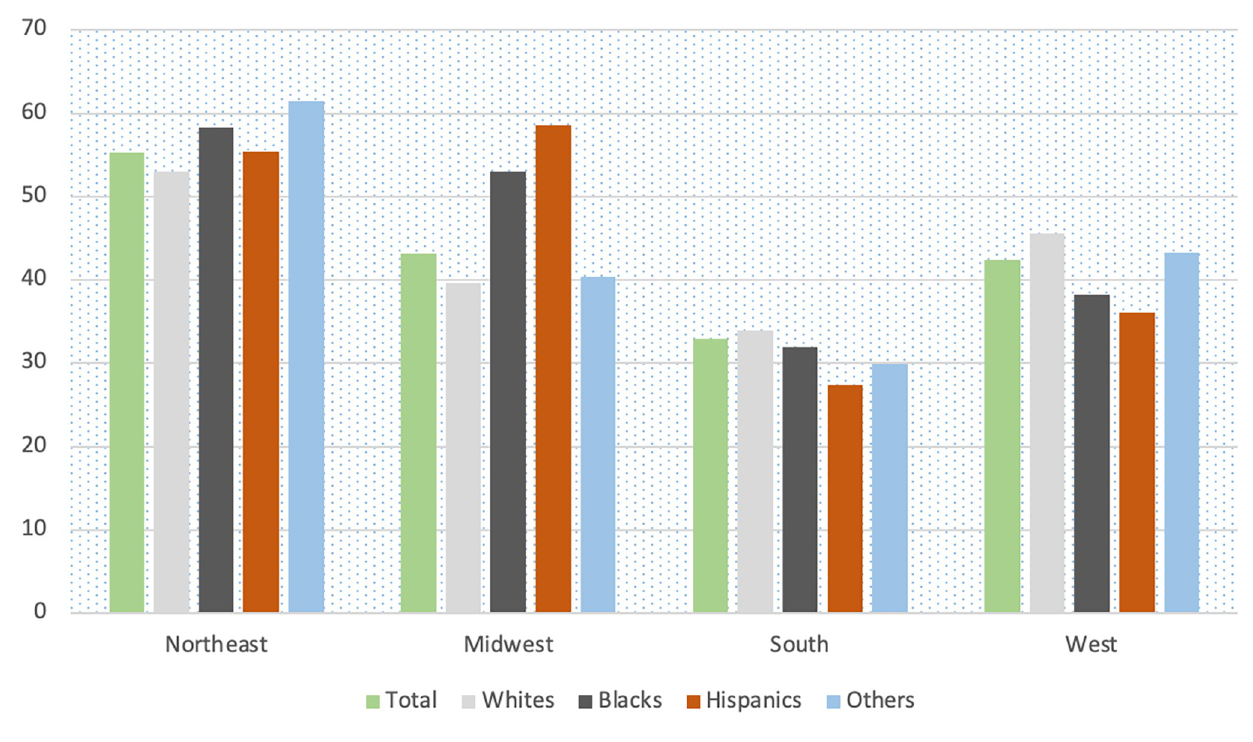
Fig 2. Unadjusted mortality rates (%) per 100 hospitalized COVID-19 patients by racial group among patients 60+ years.